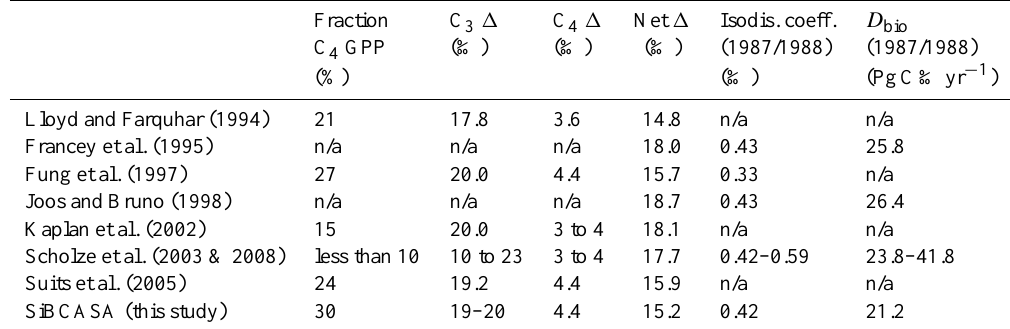
Table 2. Comparison of isotopic parameters between different modeling studies. The heterotrophic-weighted mean isodisequilibrium coeffi- cient was estimated for the period 1987/88.